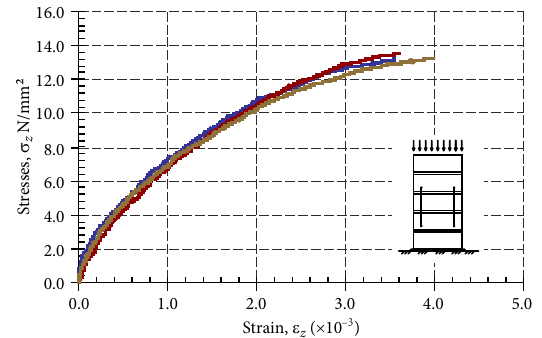
Fig. 15. The dependence of the Serial B5 masonry specimens of bed joint stress under the short-term